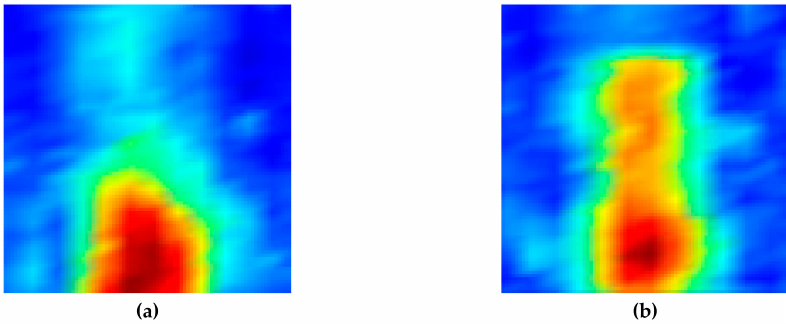
Figure 20. Ultrasonic images of a dissimilar-metal weldment specimen with notch by ( a ) a 45 ◦ oblique incidence and ( b ) 60 ◦ oblique incidence through stainless steel.